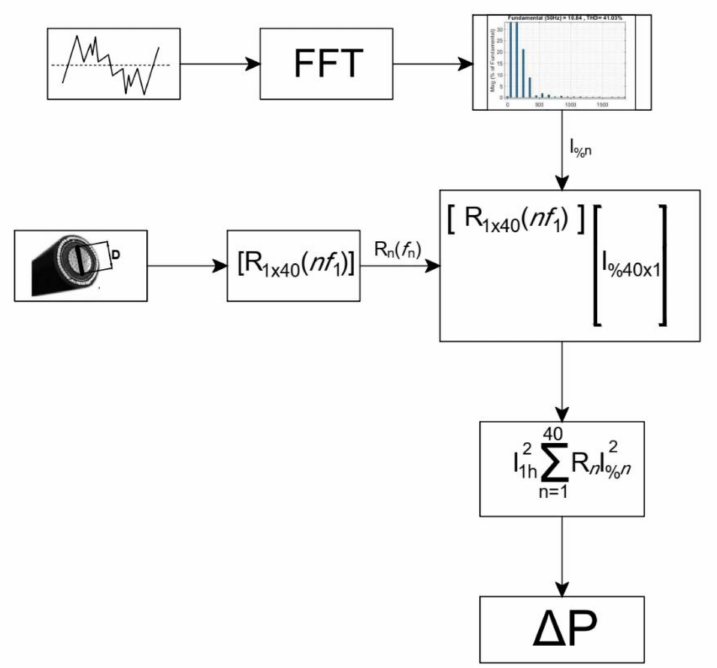
Figure 5. The graphical illustration of the proposed method (CPD) based on the penetration depth